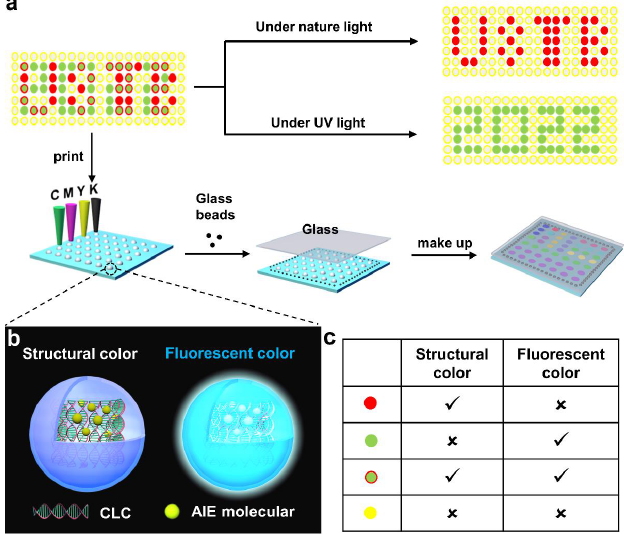
Figure 1. ( a ) Schematic of inkjet printing technology to achieve patterning of liquid crystal ink with different components. The pattern showing two kinds of distinct information demonstrates the structural color of “USTB” under natural light and the fluorescent color of “2022” under UV irra- diation. ( b ) Schematic to show FCLC microdroplets with both structure color under natural light and fluorescent color under UV irradiation. ( c ) Summarized the optical properties of 4 different LC microdroplets. Red solid circle means only structural color of CLC but not fluorescent color ; Green solid circle means only fluorescent color but not structural color; Solid green circles with red bor- ders represent both structural color and fluorescent; Yellow solid circles represent neither struc- tural color nor fluorescent.